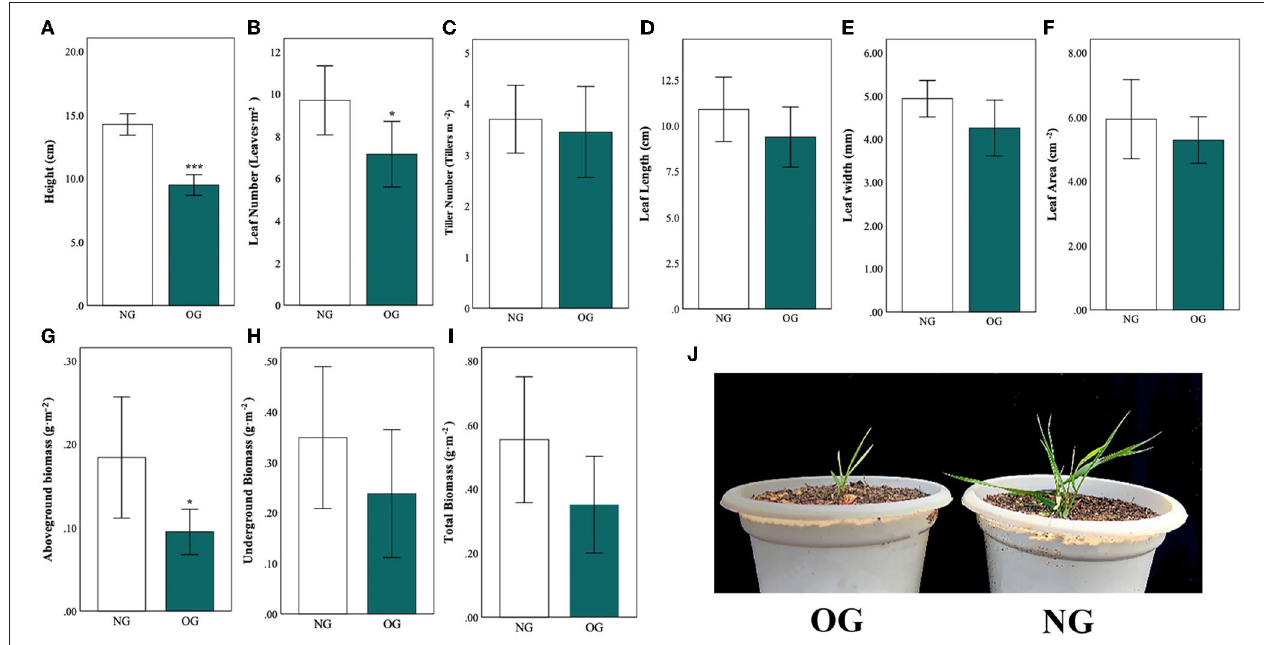
FIGURE 1 | Differences in plant morphological traits in Leymus chinensis in response to no-grazing (NG) and overgrazing (OG) conditions. (A–I) show different morphological traits, (J) comparison of early growth stage. Statistical significance is denoted by *** P < 0.001; ** P < 0.01; * P < 0.05. Error bars denote standard error of the